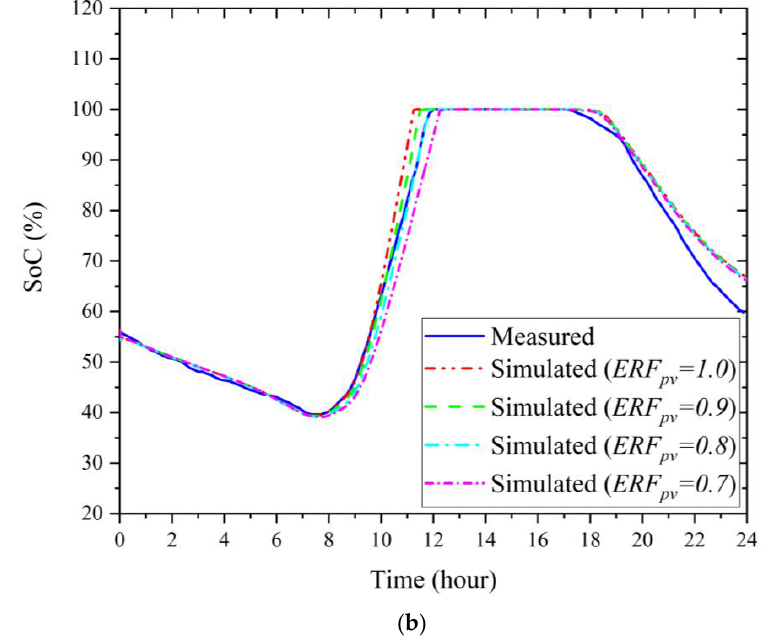
Figure 25. Additional validation results for the same day in Figure 23: ( a ) PV output power; ( b ) battery SoC%.